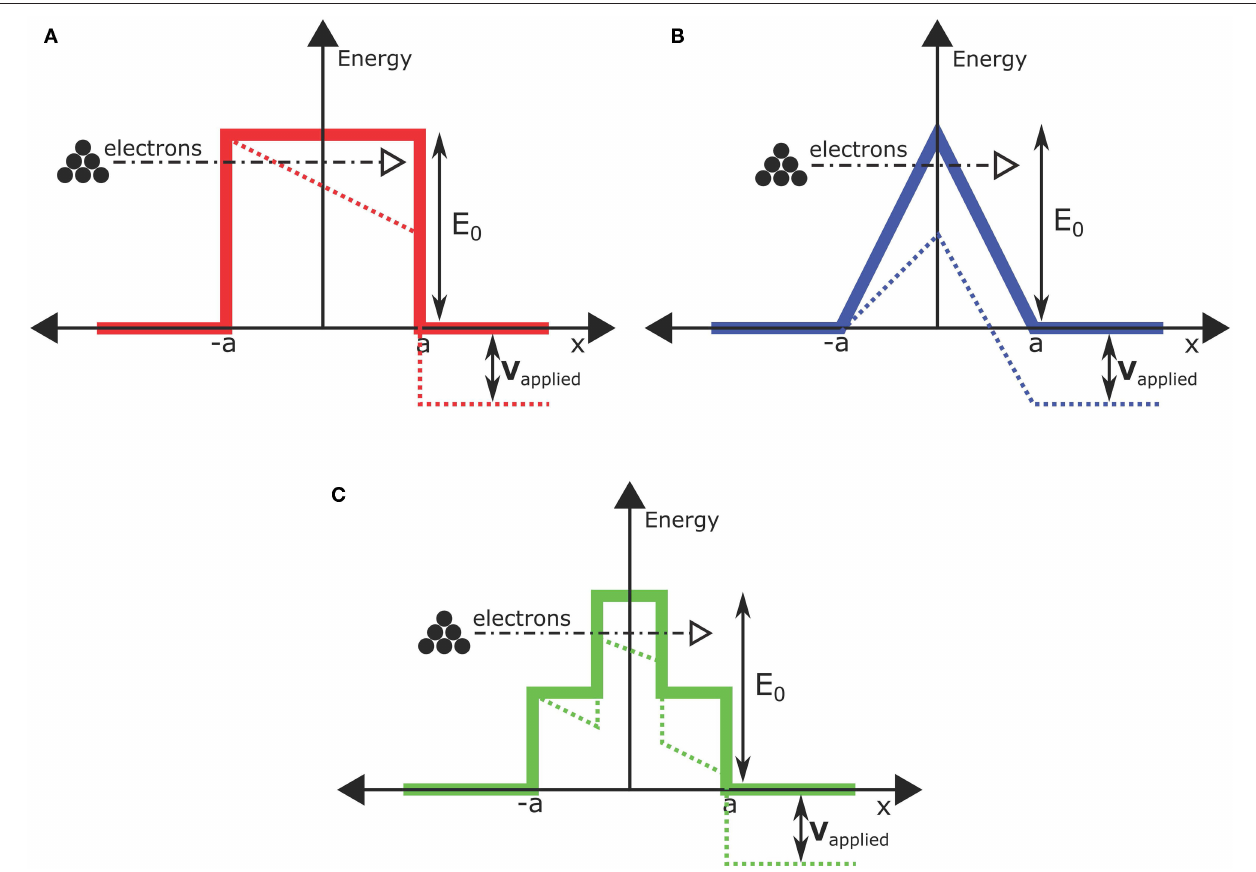
FIGURE 1 | Band diagrams of different tunnel barriers. (A) Typical uniform potential barrier; (B) triangular symmetric potential barrier; (C) staircase symmetric potential